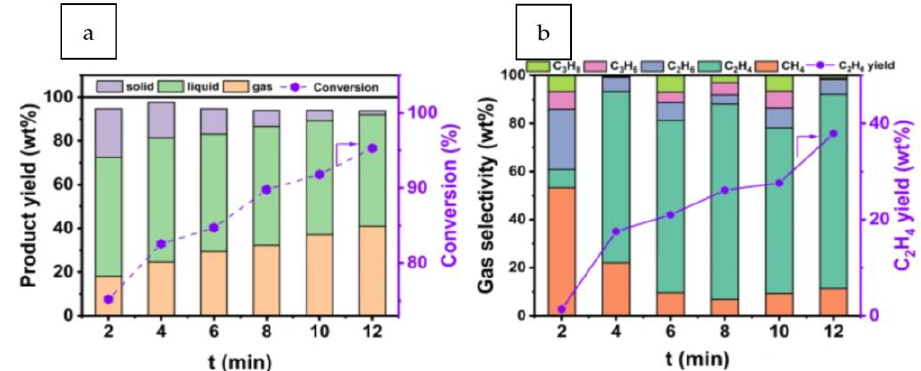
Figure 12. ( a ) Product yield and ( b ) gas selectivity of hydrogenolysis of post-consumer PS. Reprinted with permission from ref. [43].